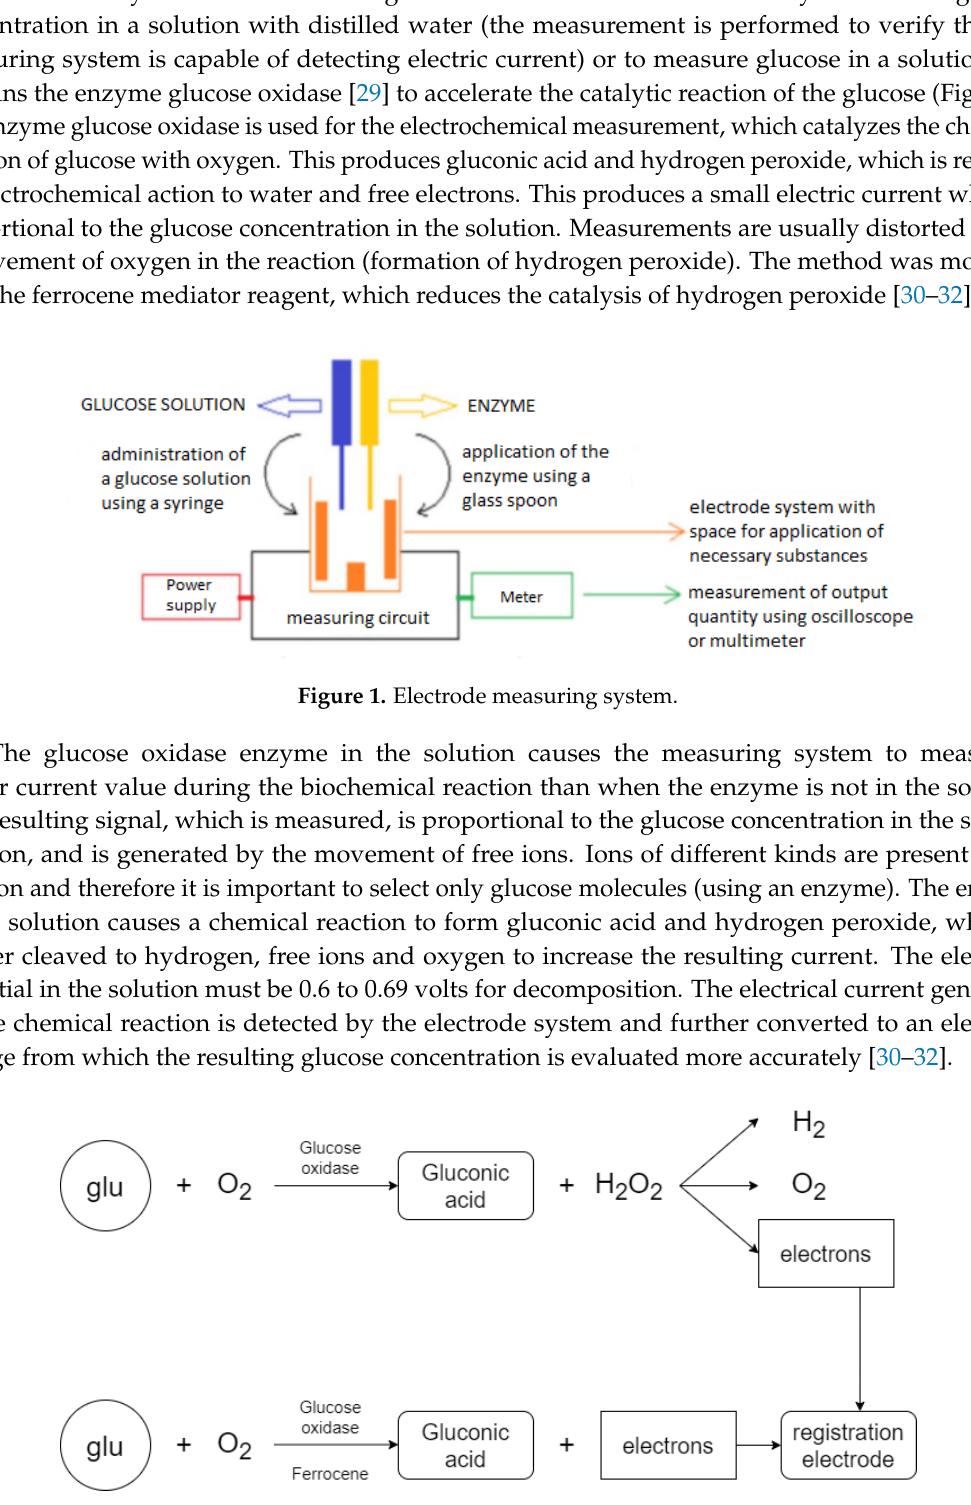
Figure 2. Reactants and chemical reaction